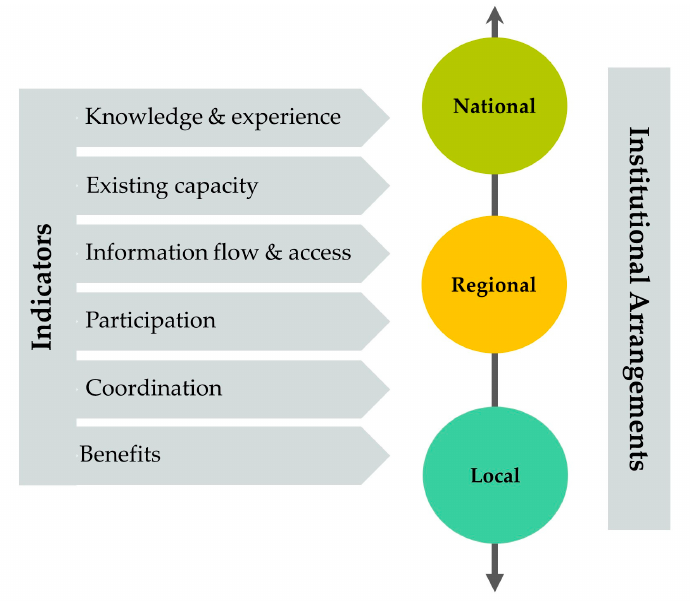
Figure 2. Indicators to assess multilevel governance for forest monitoring. Table 1. General information on the indigenous communities.